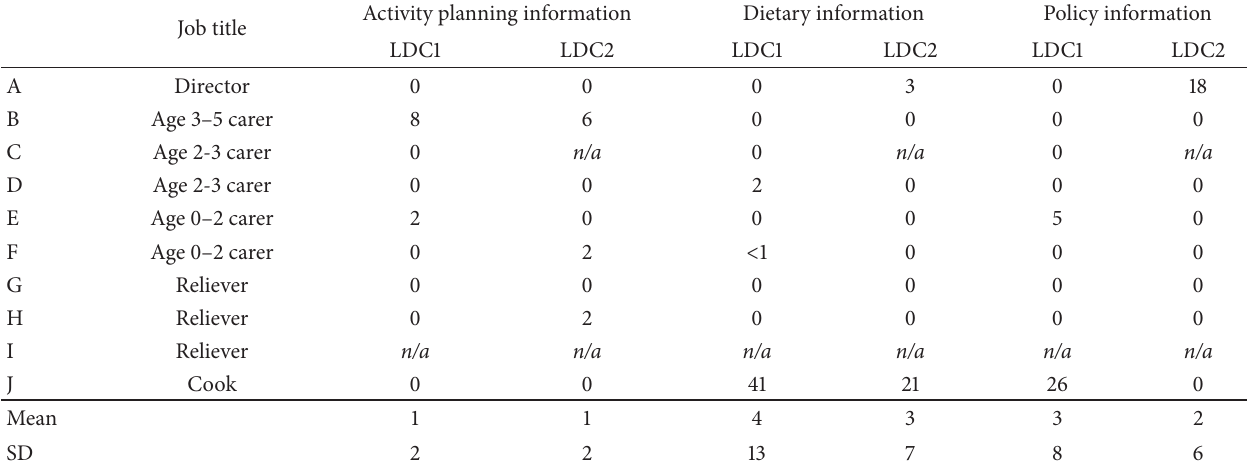
Table 2: Individual betweenness centrality scores for “provision of information”